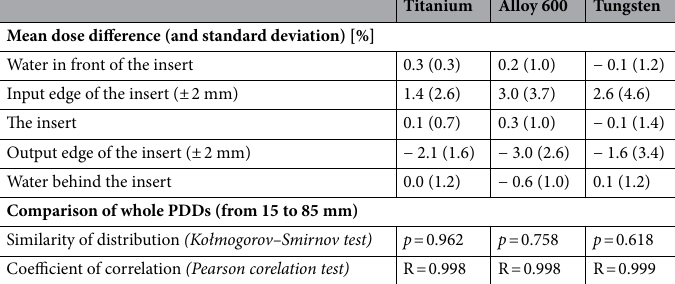
Titanium Alloy 600 Tungsten